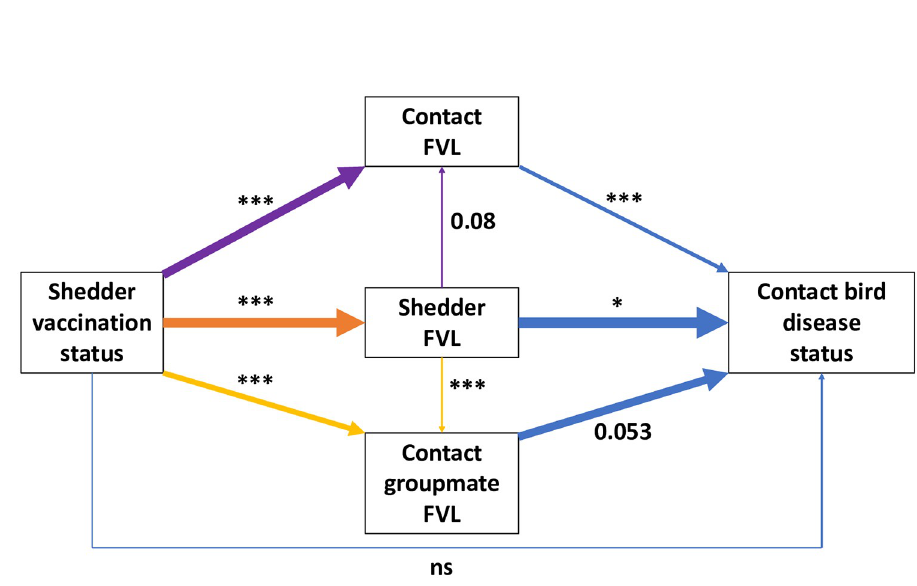
Fig 5. Diagrammatic representation of the mediating effects of viral load on contact bird binary disease status. Each arrow colour represents a different multiple regression analysis, with arrows pointing from predictors to response. Arrow thickness represents regression coefficient (all significant or marginal relationships were positive). The diagram shows that the effect of shedder FVL on contact FVL (see Table 2) fails to fully explain the shedder vaccination effect, which remains significant when both variables are included (purple arrows). The same is true for the cumulative FVL of all infected groupmates (yellow arrows). However, the 3 FVL predictor variables together completely remove the effect of shedder vaccination status (blue arrows) in explaining contact disease status (see Table 1), and this is true for all other contact disease variables (S1 Table). This implies that shedder vaccination effects on contacts are fully mediated by FVL of infected individuals in a contact group. Significance is indicated by asterisks: ��� p < 0.001, �� p < 0.01, � p < 0.05, ns = not significant. Marginally nonsignificant p -values are presented numerically. All results presented here are from models excluding the DPI by vaccination status interaction but including sex and DPI main effects (not shown, see S1 Table). Underlying data are in Edinburgh DataShare repository (https://doi.org/ 10.7488/ds/2725). DPI, days post-infection; FVL, feather viral